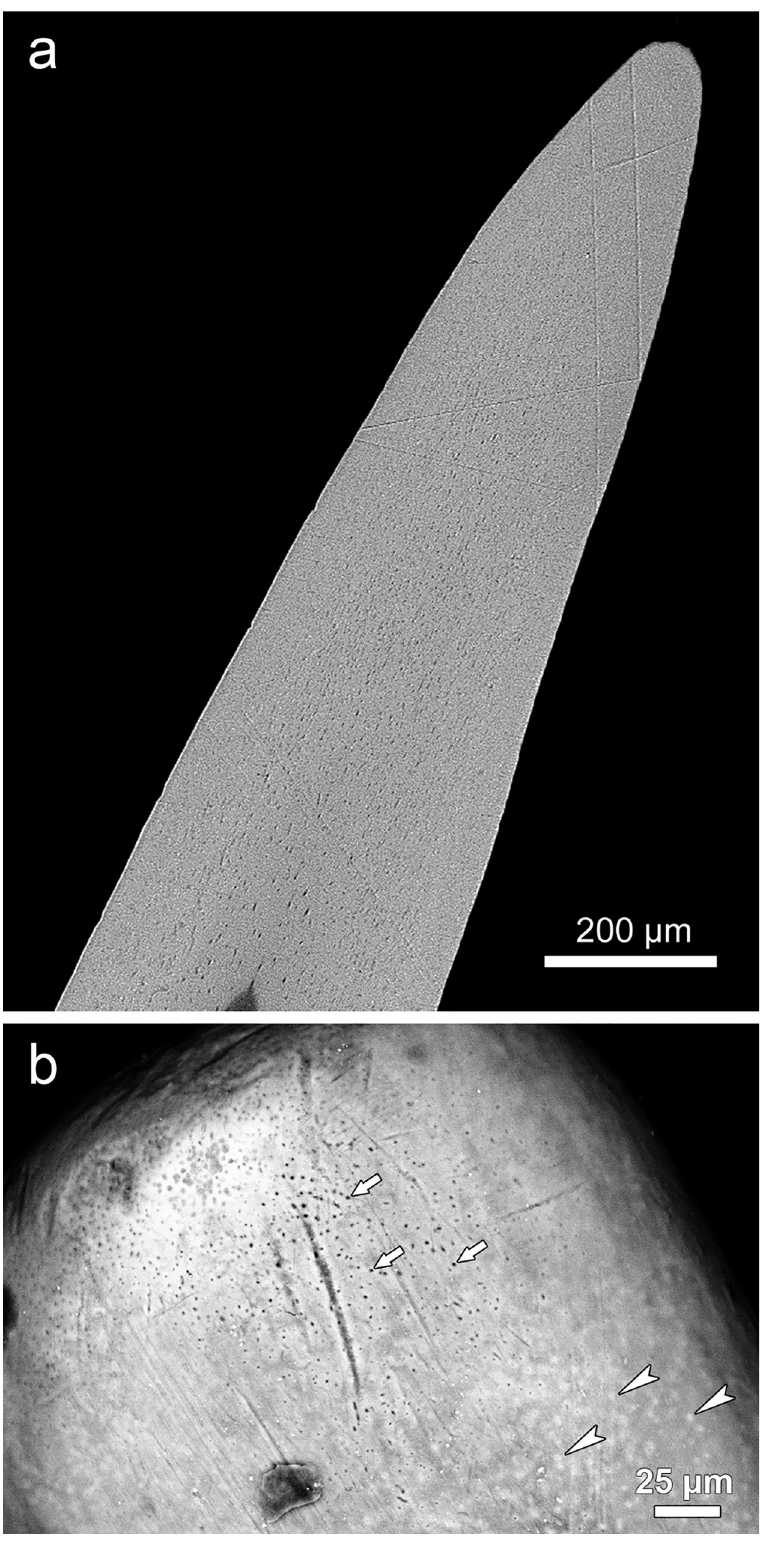
Fig 5. Tip region of oral jaw teeth. (a) SEM-BSE image of polished longitudinal section of left first dentary tooth. Note uniform gray level (indicative of homogeneous mineralization) of the dentin and lack of an enameloid cap.